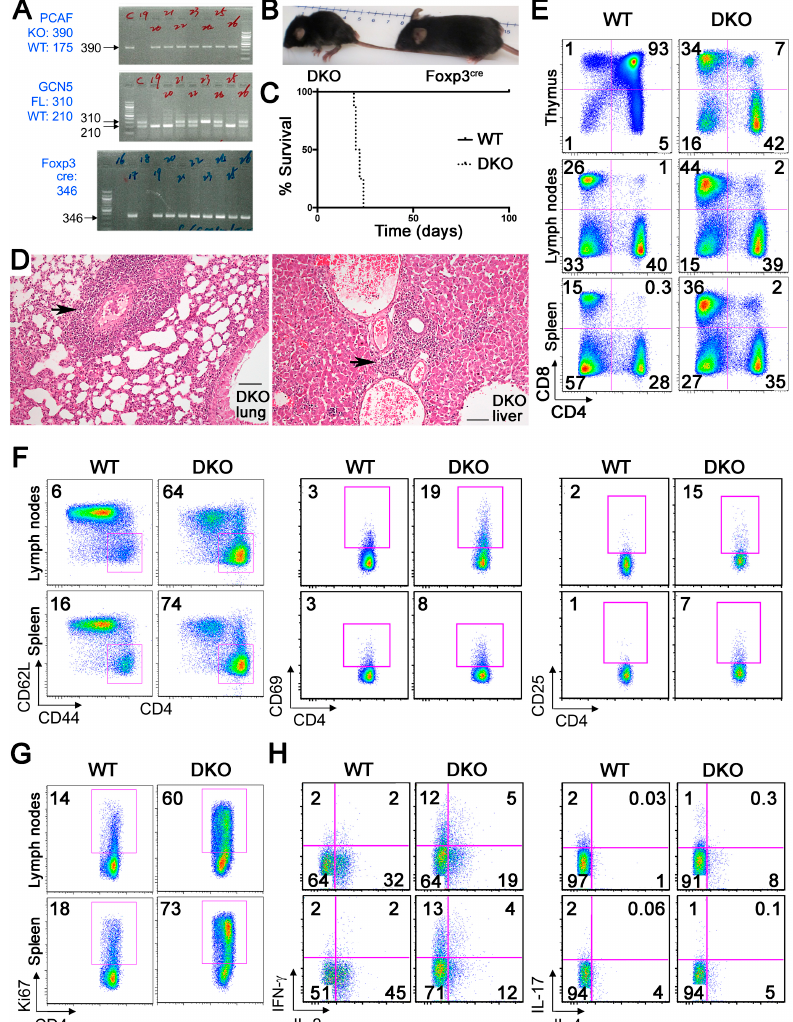
Figure 5. GCN5 and PCAF deletion in Foxp3+ Treg cells causes lethal autoimmunity. ( A ) Development of double knockout (DKO) mice. ( B ) Appearance at 3 weeks of age. ( C ) Kaplan–Meier survival curves. ( D ) Representative histology of lungs and livers in DKO mice at 3 weeks of age; arrows indicate abnormal mononuclear cell infiltrates. Scale bars = 20 microns. ( E ) Percentages of CD4+, CD8+ T cells in thymii, lymph nodes and spleens of WT versus DKO mice. ( F ) Percentages of CD44 hi CD62L lo , CD4+CD69+ and CD4+CD25+ cells in lymph nodes and spleens of WT versus DKO mice ( G ) Percentages of CD4+Ki67+ cells in lymph nodes and spleens of WT versus DKO mice. ( H ) Intracellular cytokine staining (IL-2, IFN- γ , IL-4 and IL-17) by CD4+ Teff cells from WT versus DKO mice. Cells were gated on CD4 expression, following isolation of single cells from lymph nodes and spleens, and stimulation with PMA/ionomycin for 4 h. Data are representative of 3 independent experiments.